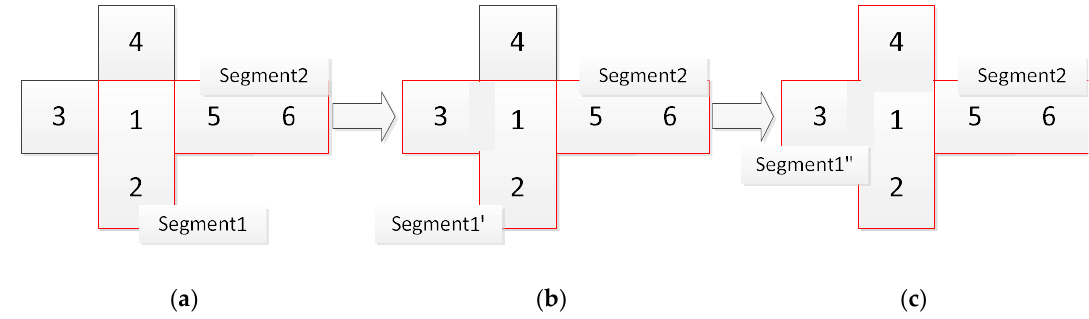
Figure 2. Sample illustrations of JM distance measure: ( a ) Segment1 is occupied by the pixel values of 1 and 2, and Segment2 is occupied by the pixel values of 5 and 6; ( b ) Segment1’ in which pixel value 3 is merged into Segment1; and ( c ) Segment1in which pixel value 4 is merged into Segment1’.